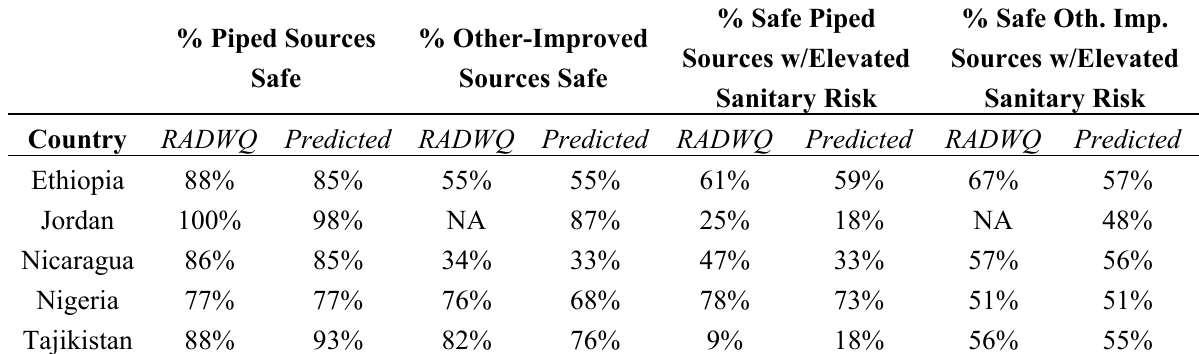
Table 7. Comparison of Measured and Predicted Proportions.